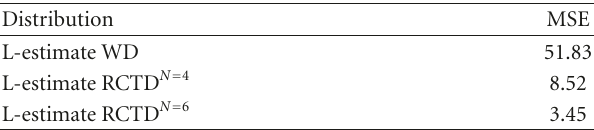
Table 3: The MSE of instantaneous frequency